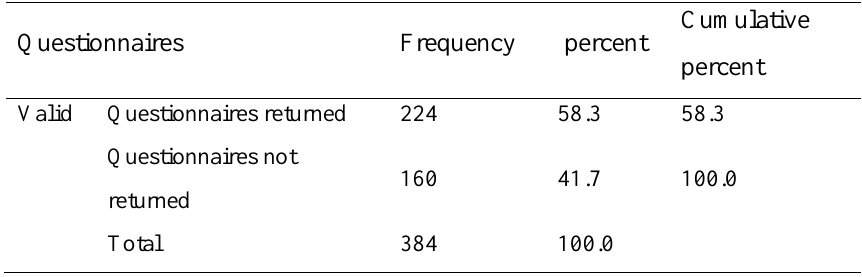
Table 3. Response Rate of Questionnaire Distribution.